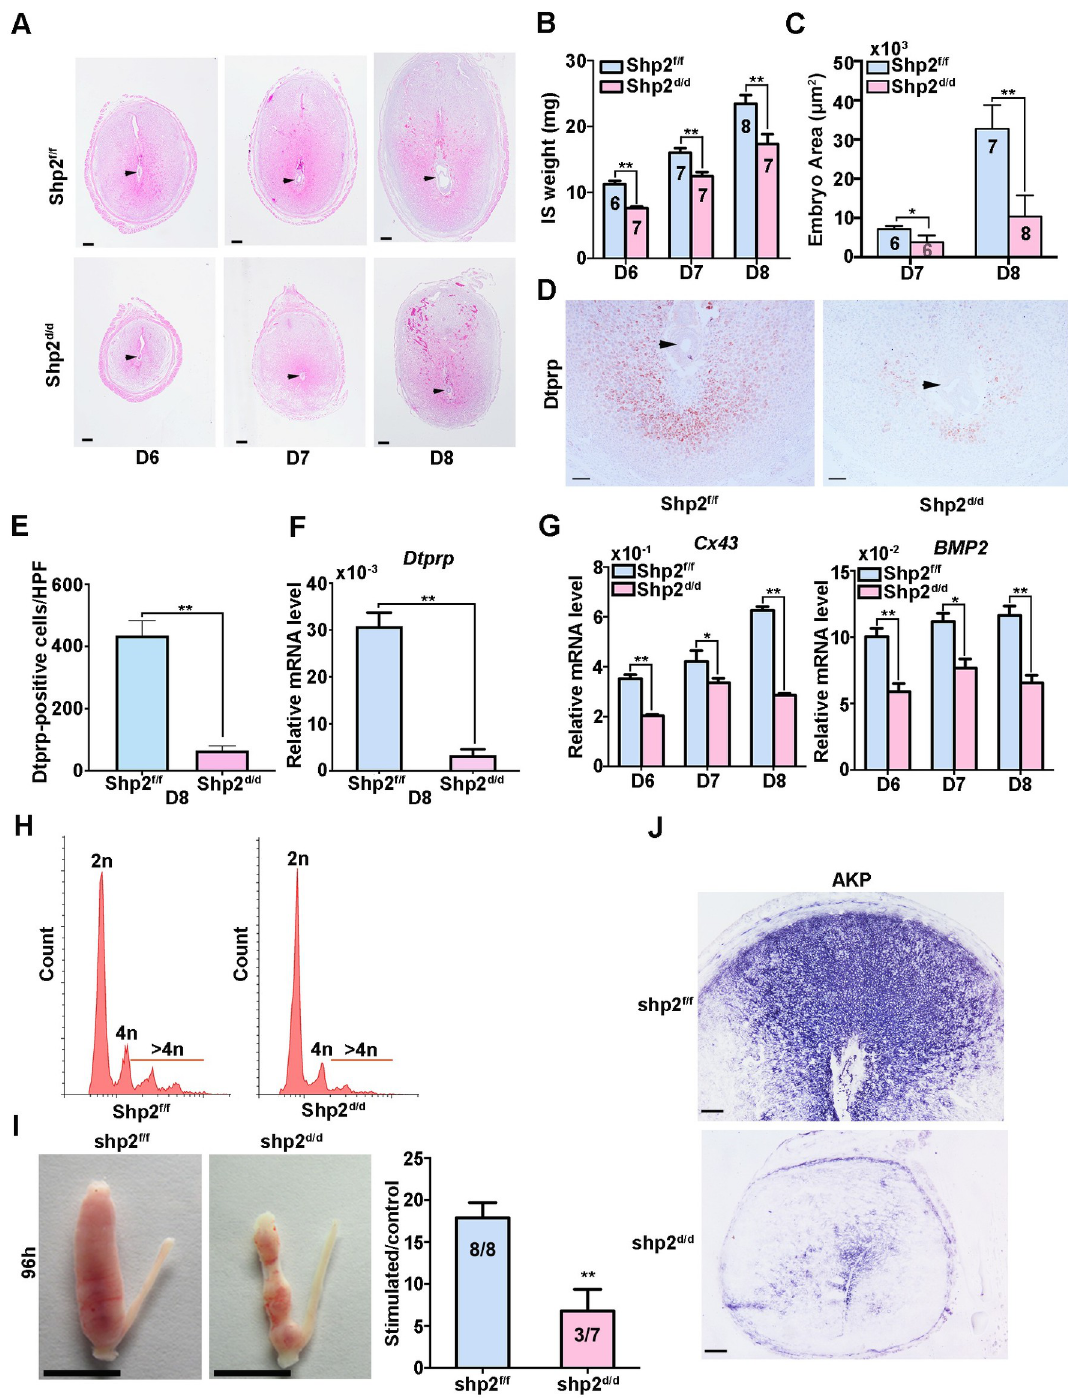
Fig 3. Shp2 deficiency impairs the process of uterine decidualization, leading to embryo growth retardation and lethality. (A) ISs collected from Shp2 f/f (n = 6/7/8) and Shp2 d/d (n = 7/7/7) mice at sequential time points (D6-D8) during pregnancy and stained with hematoxylin and eosin. The arrowheads indicate the embryos. Scale bars, 200 μ m. (B) Average wet weights of ISs on days 6–8 of pregnancy. (C) Average areas of embryos in Shp2 f/f (n = 6/7) and Shp2 d/d mice (n = 7/8) on D7-D8 of pregnancy. The numbers correspond to the number of pregnant mice examined. (D) Dtprp immunostaining of ISs collected from Shp2 f/f (n = 6) and Shp2 d/d mice (n = 6) on D8. Scale bars, 100 μ m. (E) Quantitative analysis of Dtprp-positive cells of panel D (n = 6). HPF: high power field. (F) Transcription expression of dtprp in D8 IS collected from Shp2 f/f (n = 6) and Shp2 d/d mice (n = 6) as determined by qRT-PCR.